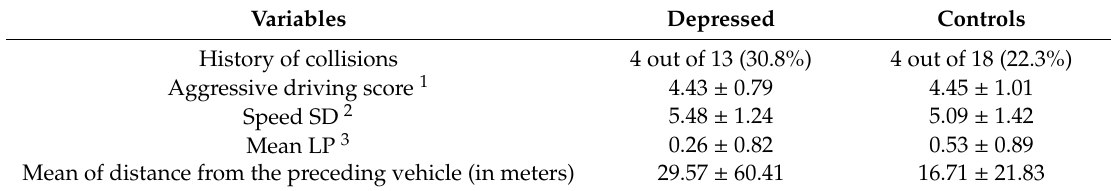
Table 2. Frequencies (%) or mean values ( ± standard deviation) of the groups of patients and